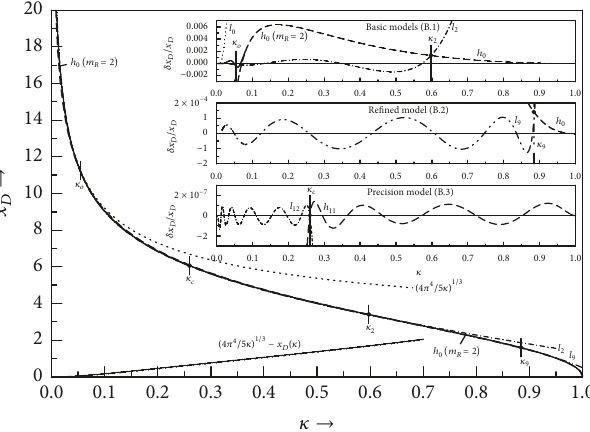
Figure 9: Exact dependence (—) of the characteristic Debye variable 𝑥 𝐷 (= Θ 𝐷 (𝑇)/𝑇 ) on the relative (normalized) magnitudes of heat capacities, 𝜅 ( = 𝐶 𝑝 (𝑇)/𝐶 𝑉ℎ (∞) ), in comparison with the low- 𝜅 asymptote, 𝑥 𝑙 0 𝐷 (𝜅) = (4𝜋 4 /5𝜅) 1/3 ( ⋅⋅⋅ ; see (B.1)), and the characteristic high- 𝜅 approximation, 𝑥 ℎ 0 𝐷 (𝜅) (––– ––; see (B.3)). Considerable reductions of maximum deviations to ± 0.13% (see the upper inset) or ± 0.0153% (see the middle inset) are achieved by means of combinations of two more elaborate, qualitatively different versions of low-to-intermediate- 𝜅 approximations, 𝑥 𝑙 2 𝐷 (0 ≤ 𝜅 ≤ 𝜅 2 ) (– ⋅ – ⋅ – ⋅ –; see (B.5a) and (B.5b)) and 𝑥 𝑙 9 𝐷 (0 ≤ 𝜅 ≤ 𝜅 9 ) (–– ⋅ – – ⋅ –; see (B.6)), in combination with the complementary high- 𝜅 curve sections, that is, 𝑥 ℎ 0 𝐷 (𝜅 2 ≤ 𝜅 ≤ 1) or 𝑥 ℎ 0 𝐷 (𝜅 9 ≤ 𝜅 ≤ 1) , respectively. From the lower inset we see that the residual deviations of the complementary high-precision formulas 𝑥 𝑙 12 𝐷 (0 ≤ 𝜅 ≤ 𝜅 𝑐 ) (see (B.8)) and 𝑥 ℎ 11 𝐷 (𝜅 𝑐 ≤ 𝜅 ≤ 1) (see (B.9)) are throughout smaller than ±